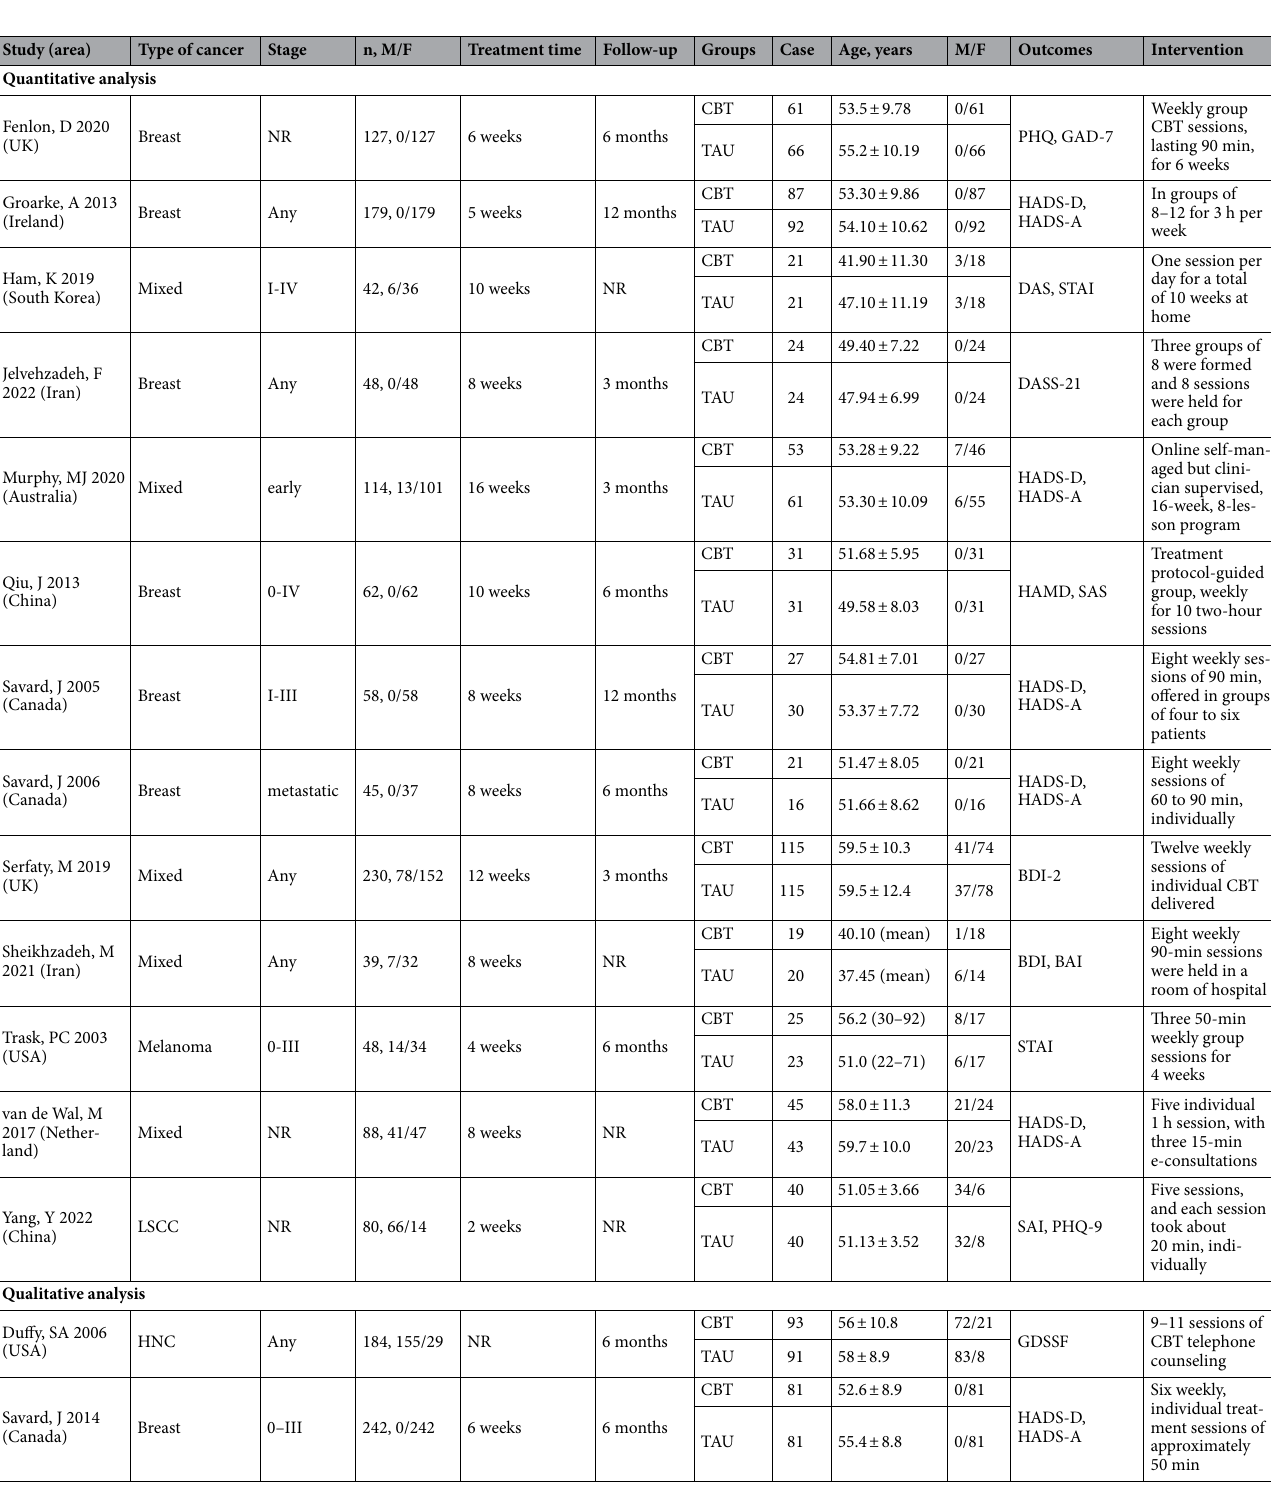
Table 1. Characteristics of the included studies. F, female; M, male; NR, not reported; HNC, Head and Neck Cancer; LSCC, laryngeal squamous cell carcinoma; GDSSF, Geriatric Depression Scale-Short Form; GAD-7, general anxiety disorder; PHQ, patient health questionnaire; STAI, State-Trait Anxiety Inventory scores; DASS- 21, The Depression Anxiety Stress Scales 21; HAMD, 17-Item Hamilton Depression Rating Scale;